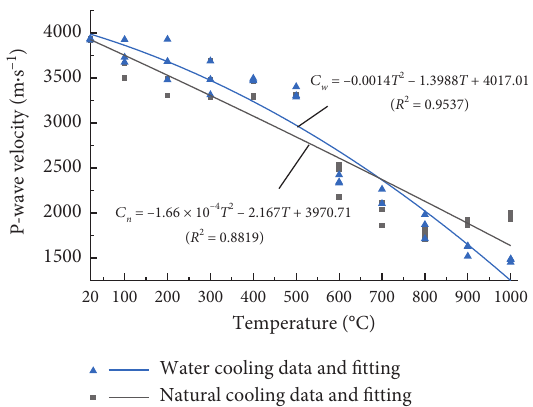
Figure 5: Density reduction rate of high temperature sandstone after two cooling methods.